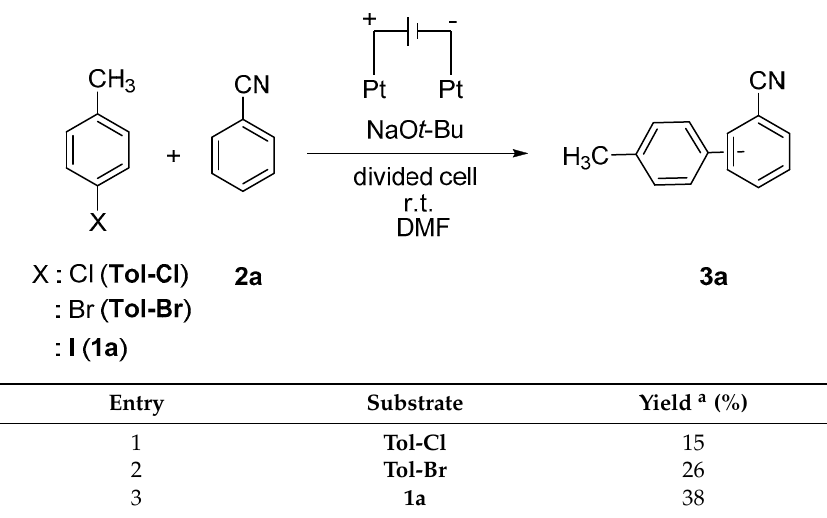
Table 1. Cathodic cross-coupling reaction using various types of aryl halides.